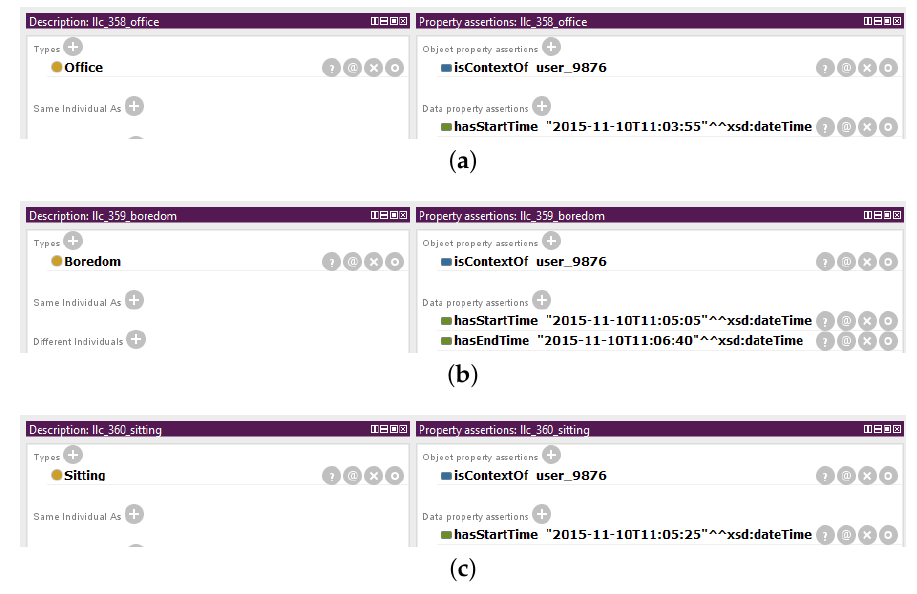
Figure 5. Representation of the instances of low-level context for the exemplary scenario by using the Mining Minds Context Ontology in Protégé. ( a ) llc_358_office is a member of the class Office ; ( b ) llc_359_boredom is a member of the class Boredom ; and ( c ) llc_360_sitting is a member of the class Sitting